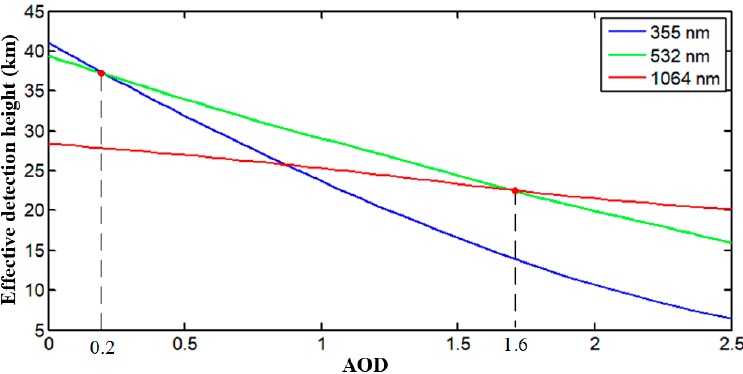
Figure 6. Effective detection heights at three wavelengths at different AOD.